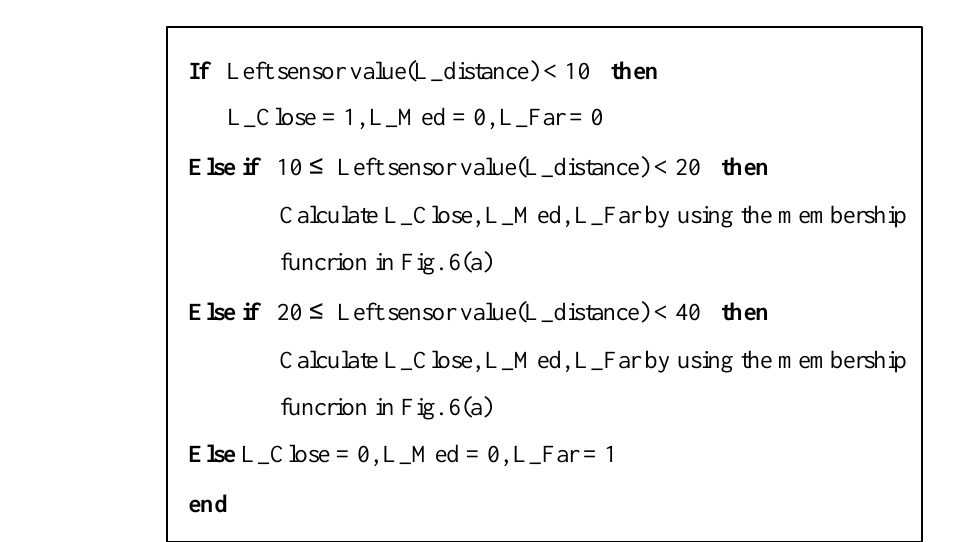
Figure 9. Flowchart of data processing in robot simulator.